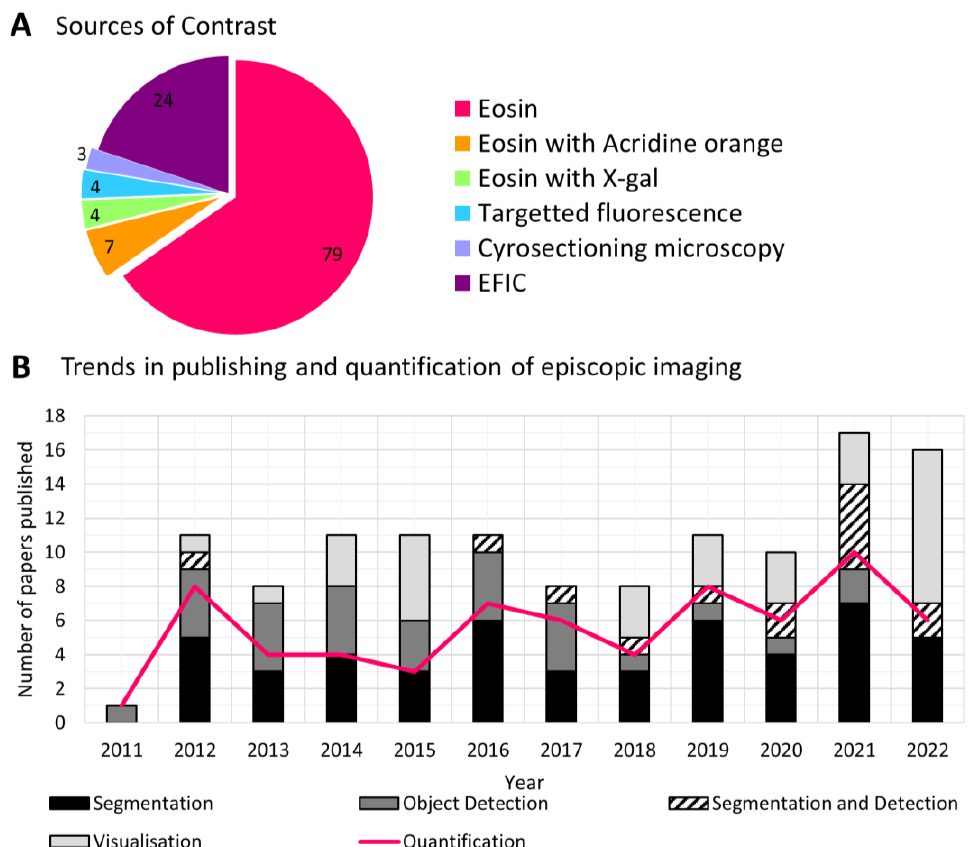
Figure 3. ( A ) The relative proportion of papers using each form of contrast is shown in a pie chart. Eosin contrast is by far the most widely used, followed by EFIC. ( B ) The trends in publishing of episcopic image data, the type of annotation performed, and the presence of quantification are summarized. The number of papers published per year has remained steady, but the proportion of those papers that include segmentation of episcopic image data has increased over time.